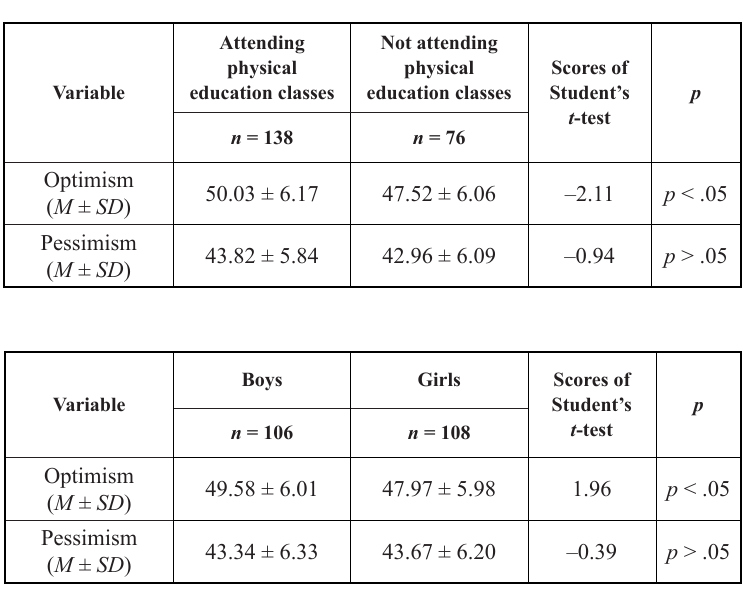
Table 2. The statistical indicators of the optimism expression among students attending and not attending physical education classes ( M ± SD )